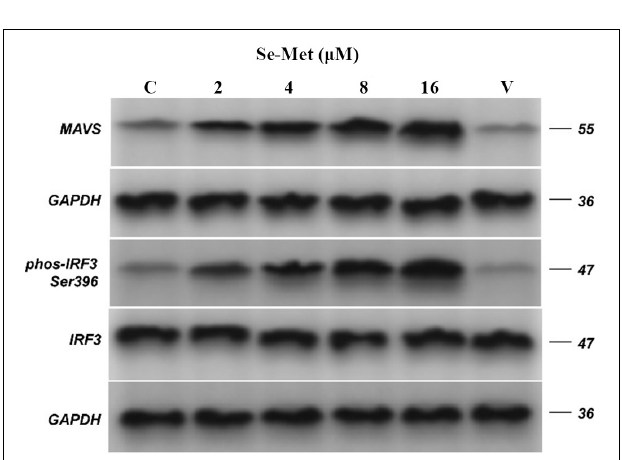
FIGURE 2 | Effects of Set-Met on the expression of MAVS protein and the phosphorylation of IRF-3 induced by PDCoV. LLC-PK cells were incubated with PDCoV for 1 h, and 2, 4, 8, and 16 µ M of Se-Met was added. The expression of MAVS protein and the phosphorylation of IRF-3 were detected by western blot. Results were mean ± SD for three individual